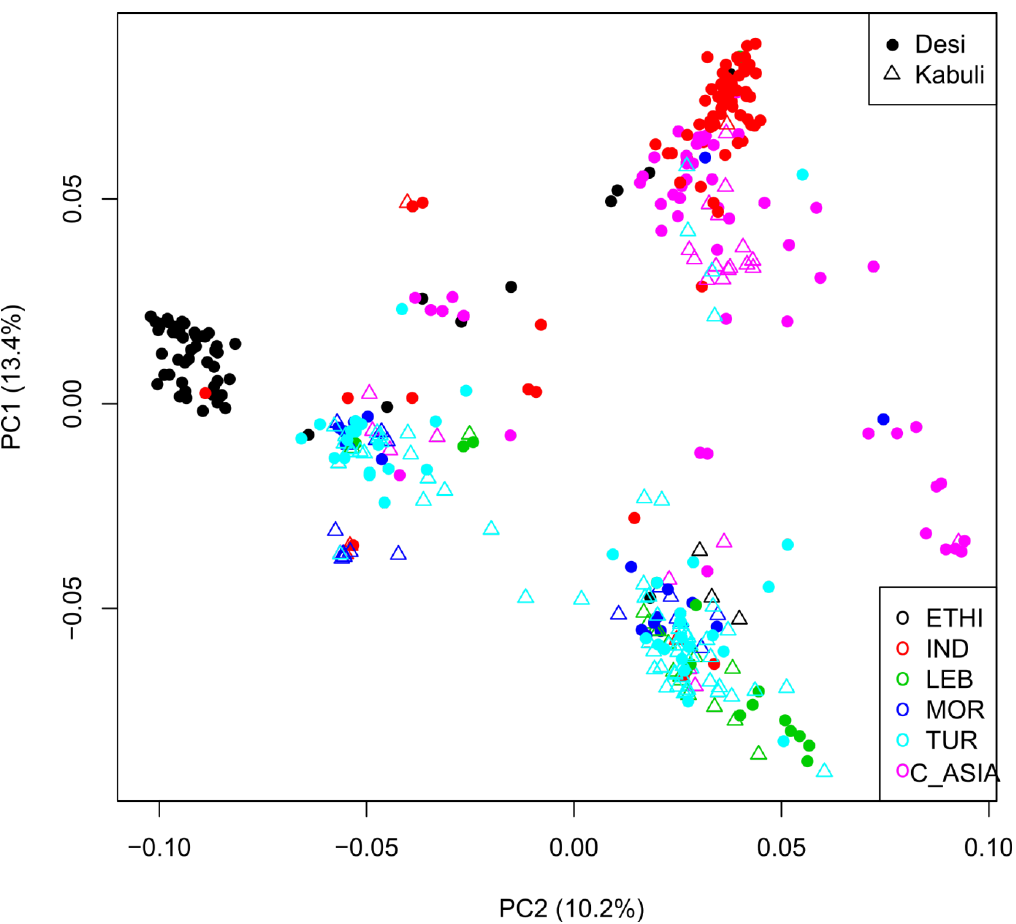
Figure 4. Scatter plots of the first two principal components of the principal component analysis (PCA) based on 2579 SNPs. Each dot represents an accession. Desi varieties are shown as asterisks and Kabuli as